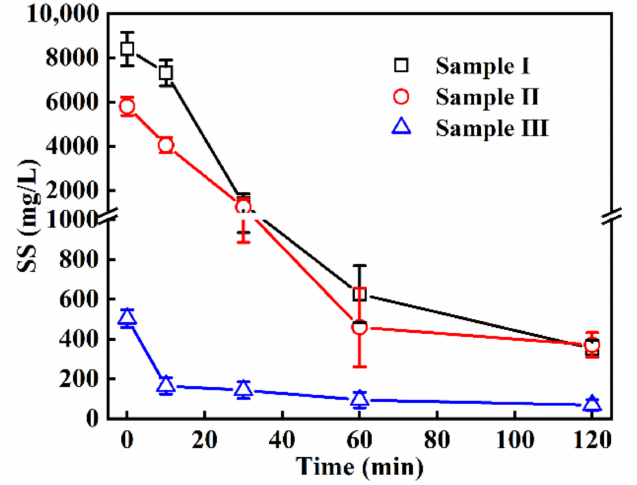
Figure 3. Changes in SS in wastewater in EO treatment at 50 mA/cm 2 current density.